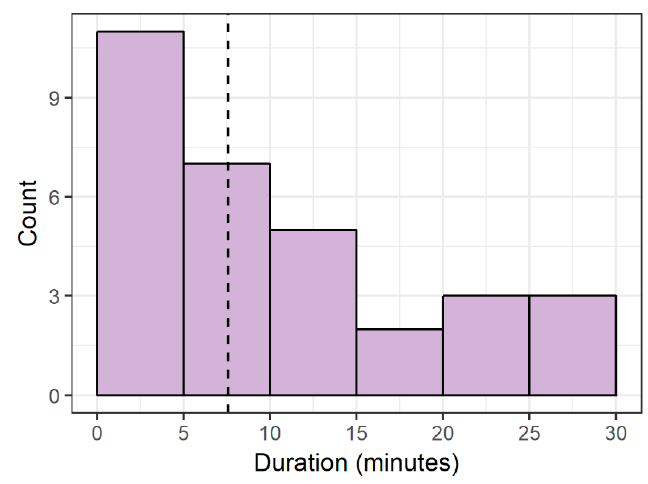
Figure 7. Number of heightened-shoaling episodes by duration (dashed vertical line represents the median heightened-shoaling duration; zebrafish housed in naturalistic tanks; n = 6 tanks, 10 zebrafish per tank; 10 days selected to observe from a 6-month period; 31 episodes of heightened-shoaling).